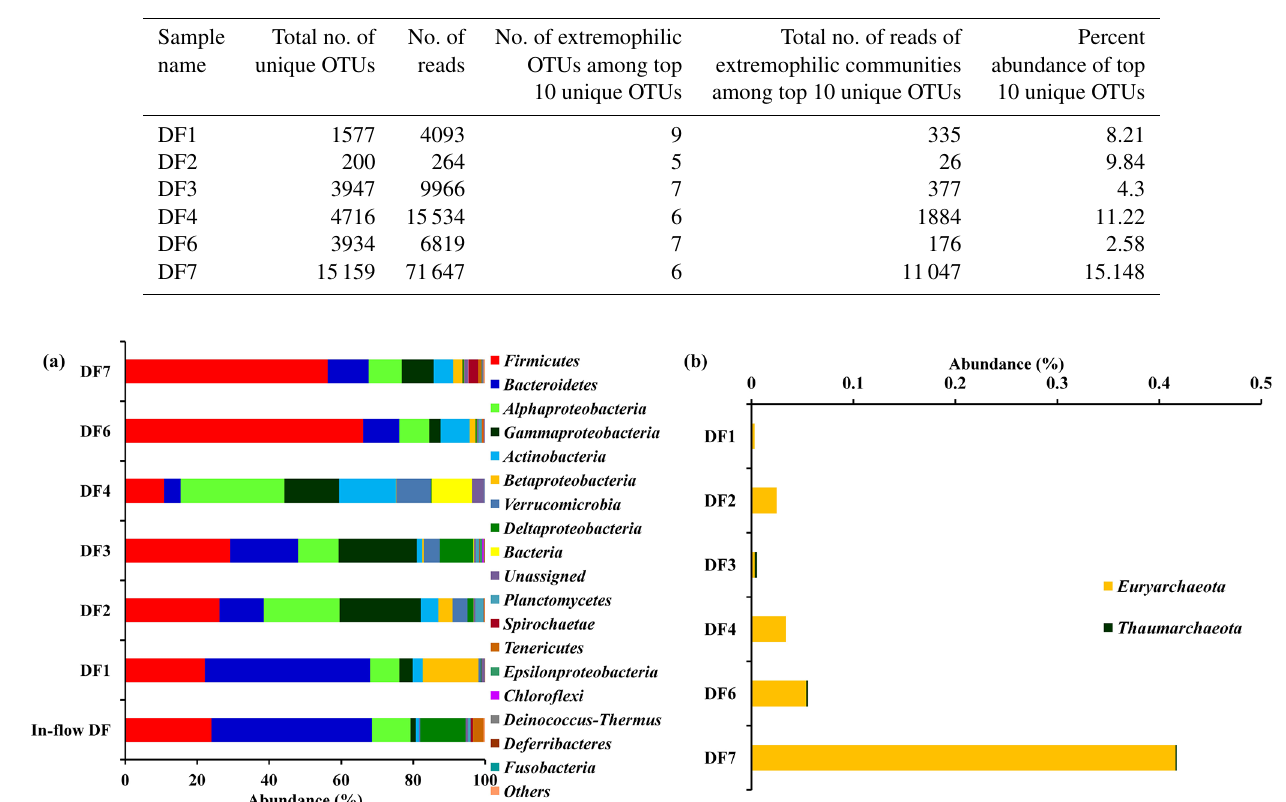
and DF7 respectively. Actinobacterial core OTUs in gen- eral constituted 2 % to 9 % of the communities, except for DF4 where these OTUs represented 53 % of total